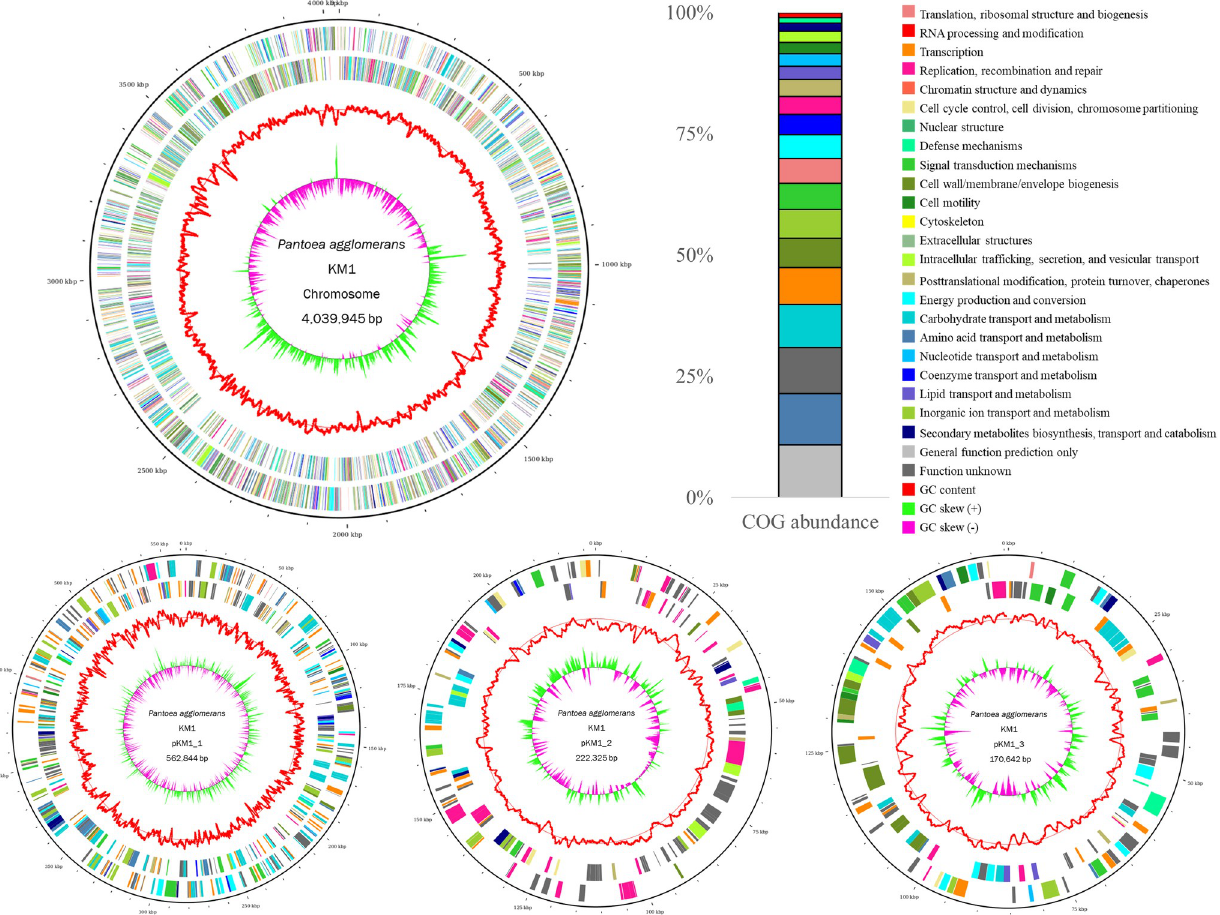
Fig 1. The circular genome maps of the P . agglomerans KM1 draft genome. Genome map showing the features of P . agglomerans KM1 chromosome and plasmids pKM1_1, pKM1_2, and pKM1_3. Circles illustrate the following from outermost to innermost rings: (1) forward CDS, (2) reverse CDS, (3) GC content, and (4) GC skew. All the annotated open reading frames (ORFs) are colored differently according to the COG assignments. Stacked bar chart shows the relative abundance (%) of COG categories calculated based on the total number of predicted ORFs present in the annotated genome.